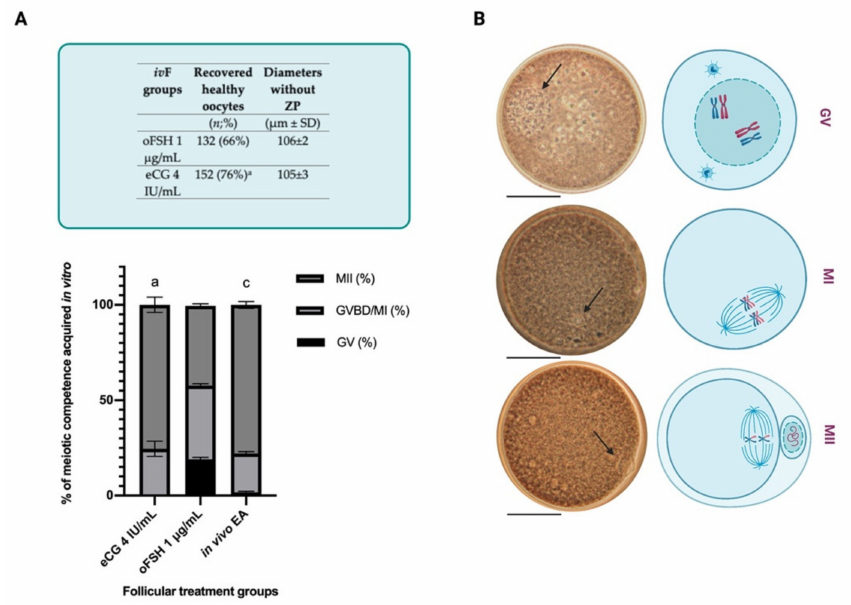
Figure 5. ( A ) Upper panel: table summarizing the number of recovered healthy oocytes and their mean diameters at the end of iv F culture. Letters indicate significant differences: a eCG 4 IU/mL vs. oFSH 1 µ g/mL. Lower panel: percentage of the oocyte meiotic competence acquired in vitro. Different nuclear stages were characterized. Letters indicate significant differences between a eCG 4 IU vs. FSH 1 µ g/mL; c FSH 1 µ g/mL vs. in vivo EA. Three independent biological replicates were performed with 66, 67, and 67 follicles per group (eCG 4 IU/mL and oFSH 1 µ g/mL). For each iv F group (oFSH 1 µ g/mL and eCG 4 IU/mL) 132 and 152 follicles, respectively, were analyzed at the end of the in vitro culture for both follicular and oocyte performance. Only those follicles that differentiated the follicular antrum, identified on the stereomicroscope as a transparent cavity filled with follicular fluid, were tested. For each iv F group (oFSH 1 µ g/mL and eCG 4 IU/mL), 132 and 152 healthy oocytes were recovered and analyzed at the end of the in vitro culture to test the oocyte performance. Only the oocytes retrieved from follicles that differentiated the follicular antrum, identified on the stereomicroscope as a transparent cavity filled with follicular fluid, were tested. ( B ) Images of oocyte nuclear stages. GV: Germinal Vesicle Break Down; MI: Metaphase 1; MII: Metaphase II (Lacmoid solution staining, 40 × magnification; scale bar: 50 µ m). Panel created